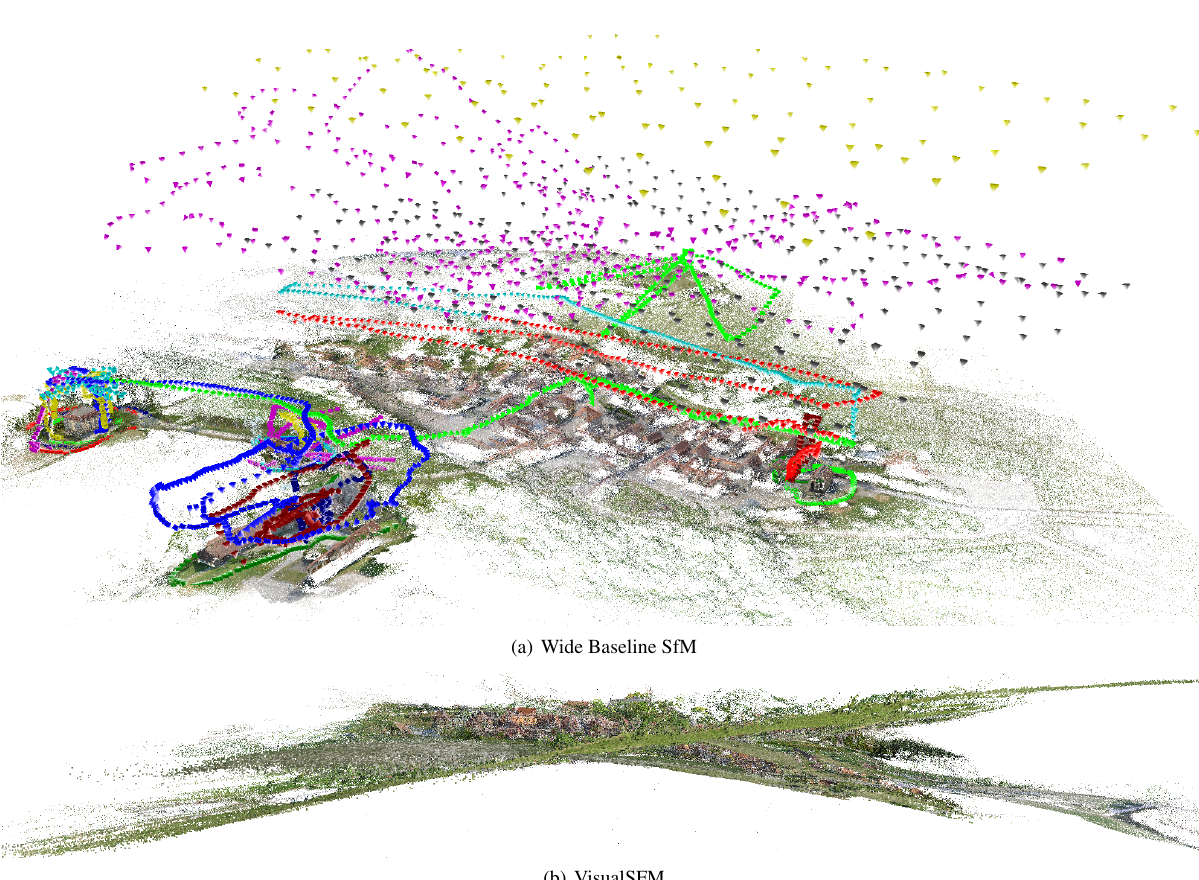
Figure 7. Image set Village containing 3531 images acquired from the ground and from various Unmanned Aerial Systems. Recon- structed camera poses are visualized by colored pyramids, where each color represents a different camera type. Registration obtained using the proposed SfM approach is shown in (a), whereas (b) shows the erroneous reconstruction produced by